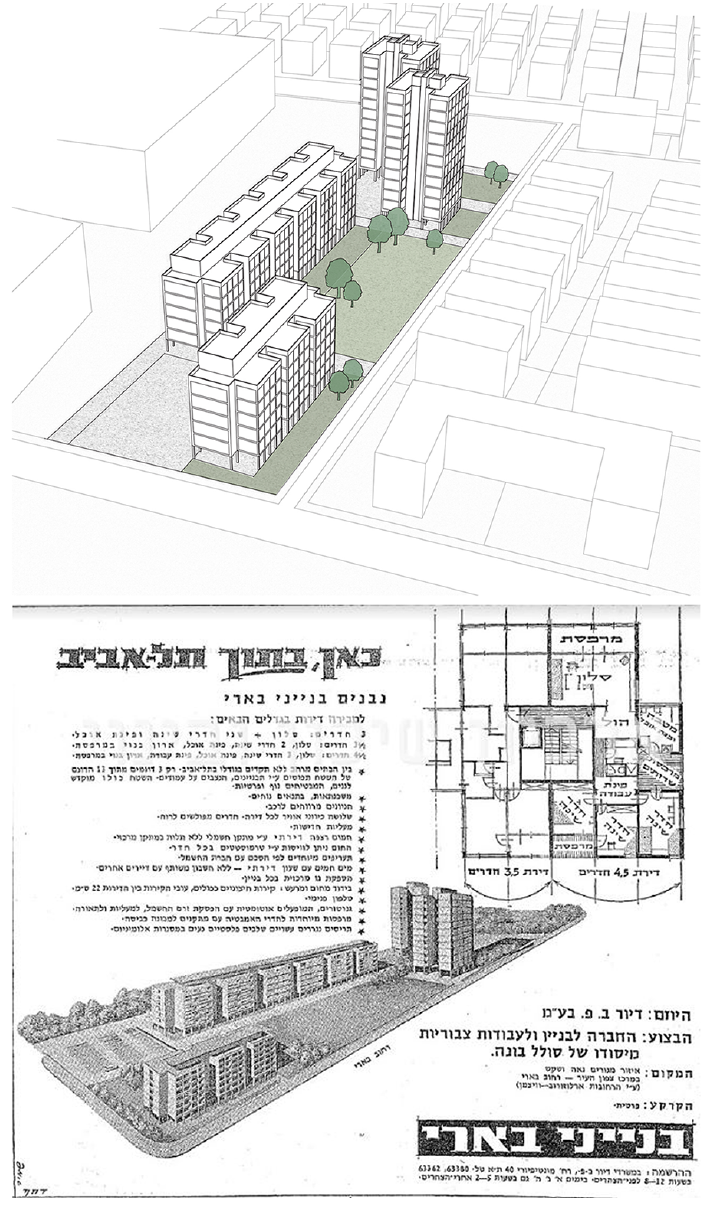
Figure 13. Be’eri estate. Top: Scheme by the authors. Bottom: Advertisement for the estate from 1963. Source: “Be’eri Dwellings”,